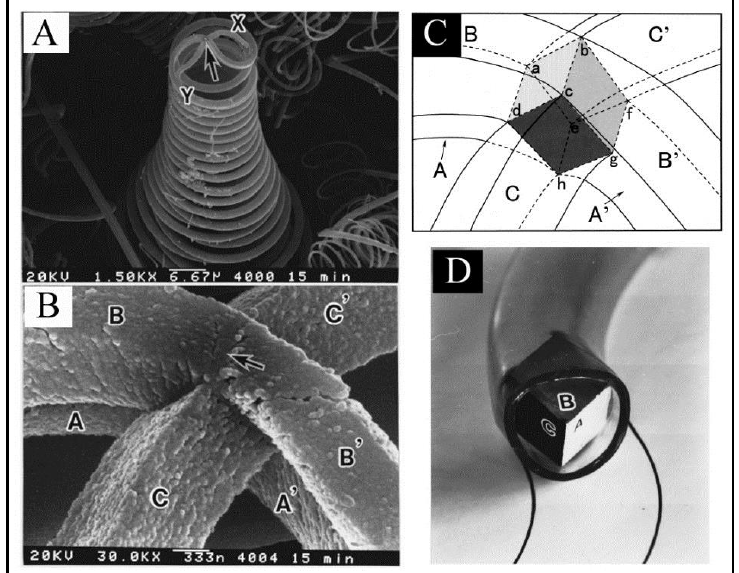
Figure 10. ( A ) carbon coils during the initial growth stage;and ( B ) an enlarged view. Arrow indicates a Ni catalyst grain, X and Y : paired coils, A, B, C, A’, B’, C’: carbon fibers grown from a Ni catalyst grain (arrow); ( C ) Postulated Ni catalyst grain. a‒h: cubic Ni grain embedded in a node of six fibers; ( D ) 3D growth model of the carbon coils. A‒C: three crystal faces, order of the catalytic activity for the carbon deposition: A > B > C ([7], Motojima and Chen,